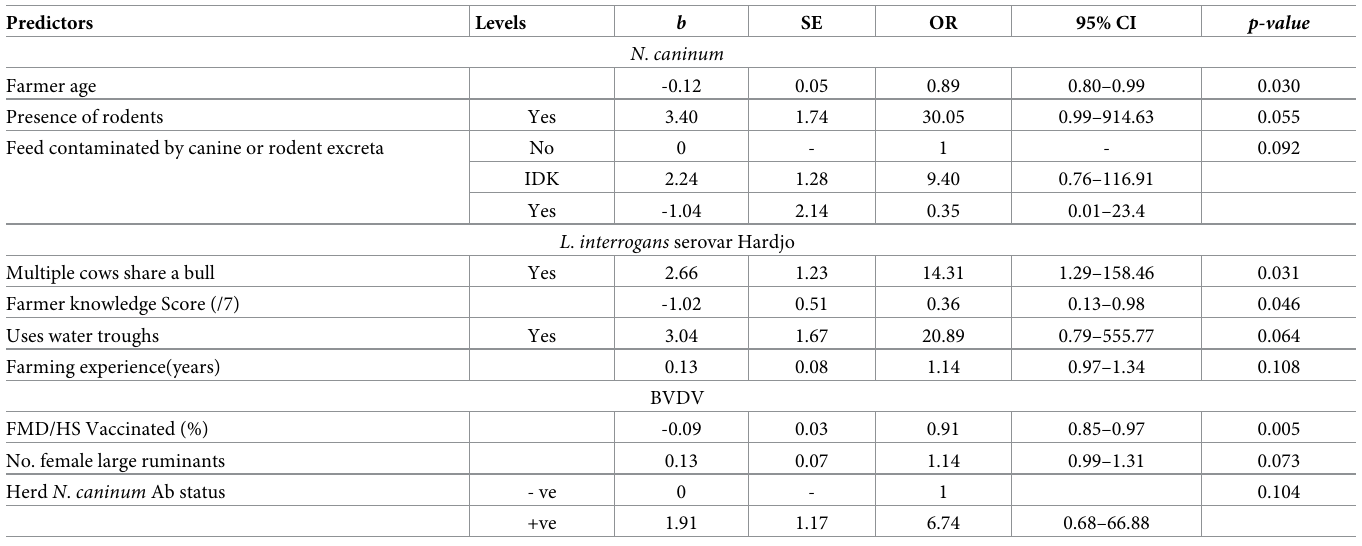
Table 9. Herd-level risk factors associated with Neospora caninum , Bovine viral diarrhoea virus (BVDV) and Leptospira interrogans serovar Hardjo seroprevalence in cattle and buffalo in Lao PDR from multivariable logistic generalised linear mixed models.